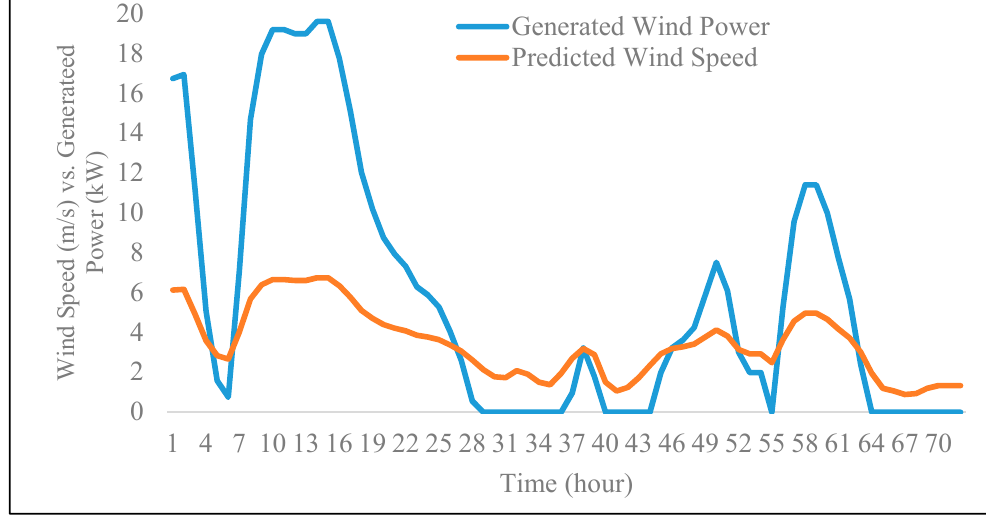
Figure 17. Predicted wind speed for three days and associated power generated by wind turbine.